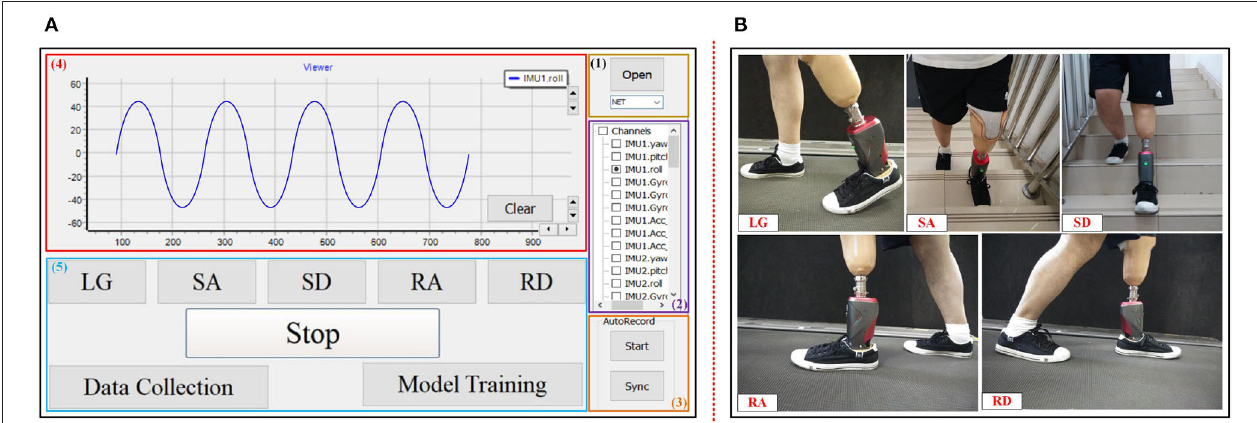
FIGURE 3 | The designed interaction platform and experimental task of the study. (A) The designed interaction interface for the study. (1) Wireless connection option with prosthesis. (2) Signal channel. (3) Raw data recording. (4) Signal display. (5) Interactive operation for experimenter. (B) Subject wears the robotic prosthesis to finish five locomotion modes: LG, SA, SD, RA, and RD.